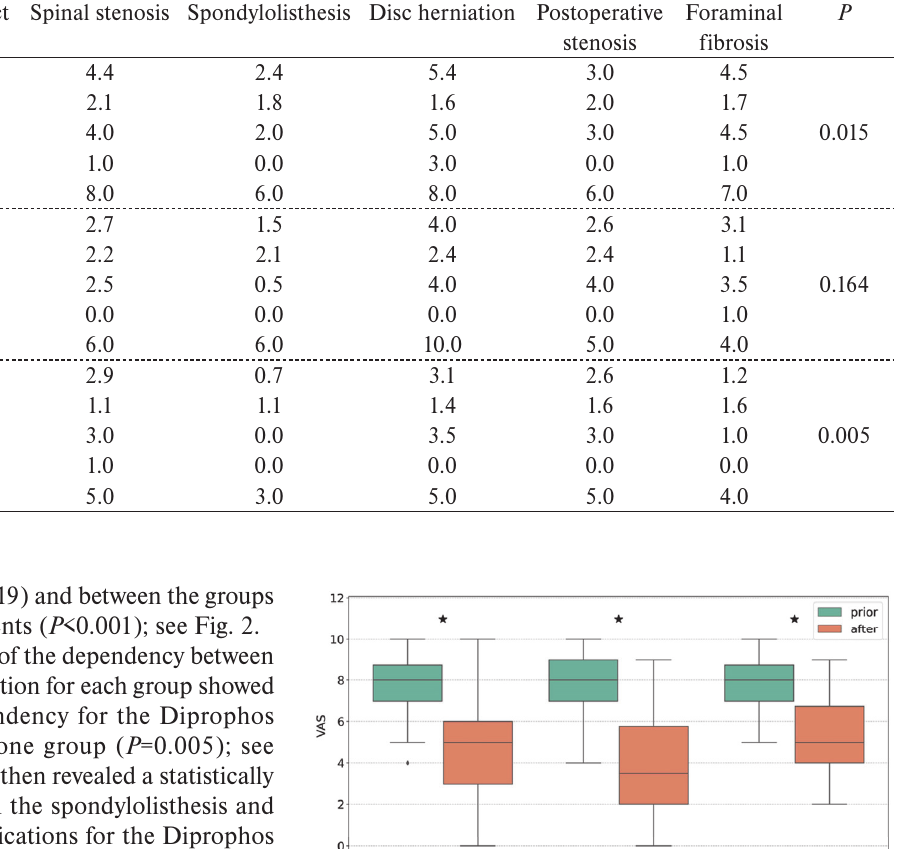
Table 3. Treatment effect (VAS change prior to and after therapy) for individual drugs and indications. Treatment effect Spinal stenosis Spondylolisthesis Disc herniation Postoperative